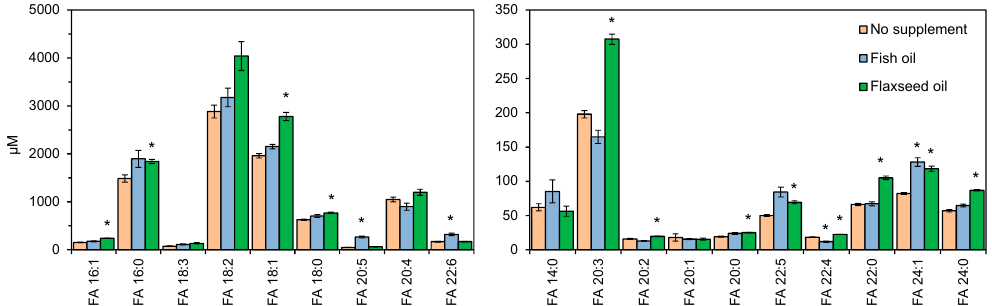
Figure 5. Total fatty acyl (FA) levels in serum from human subjects supplemented with fish oil or flaxseed oil, and subjects receiving no dietary intervention (SRM 2378). Serum lipids were subjected to acid-catalyzed hydrolyzed with H 218 O and analyzed by high resolution Fourier transform mass spectrometry (FTMS). Data represent average ± SD ( n = 4, independently prepared and analyzed samples). * p < 0.001 (unpaired, two-sided Student’s t -test with comparison to “No supplement”).